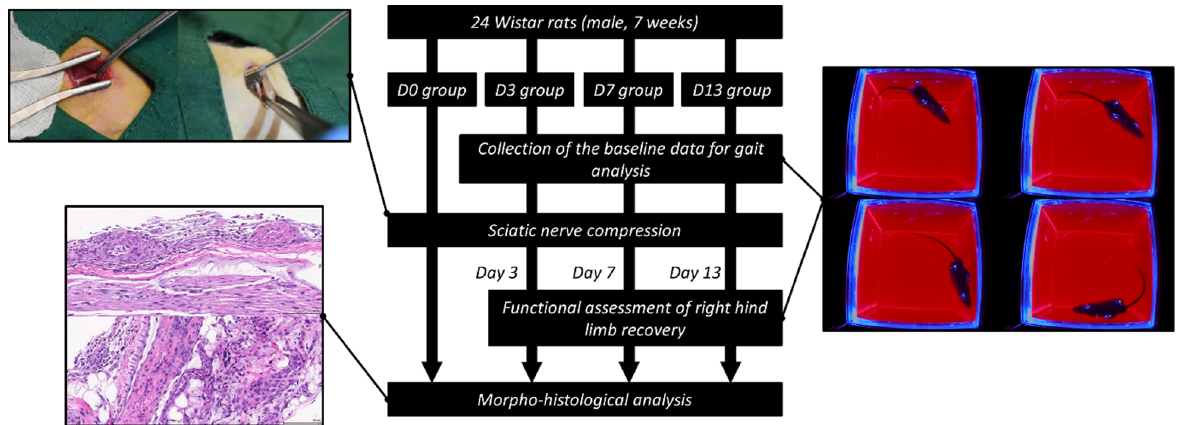
Figure 2. Overview of the experimental protocol.